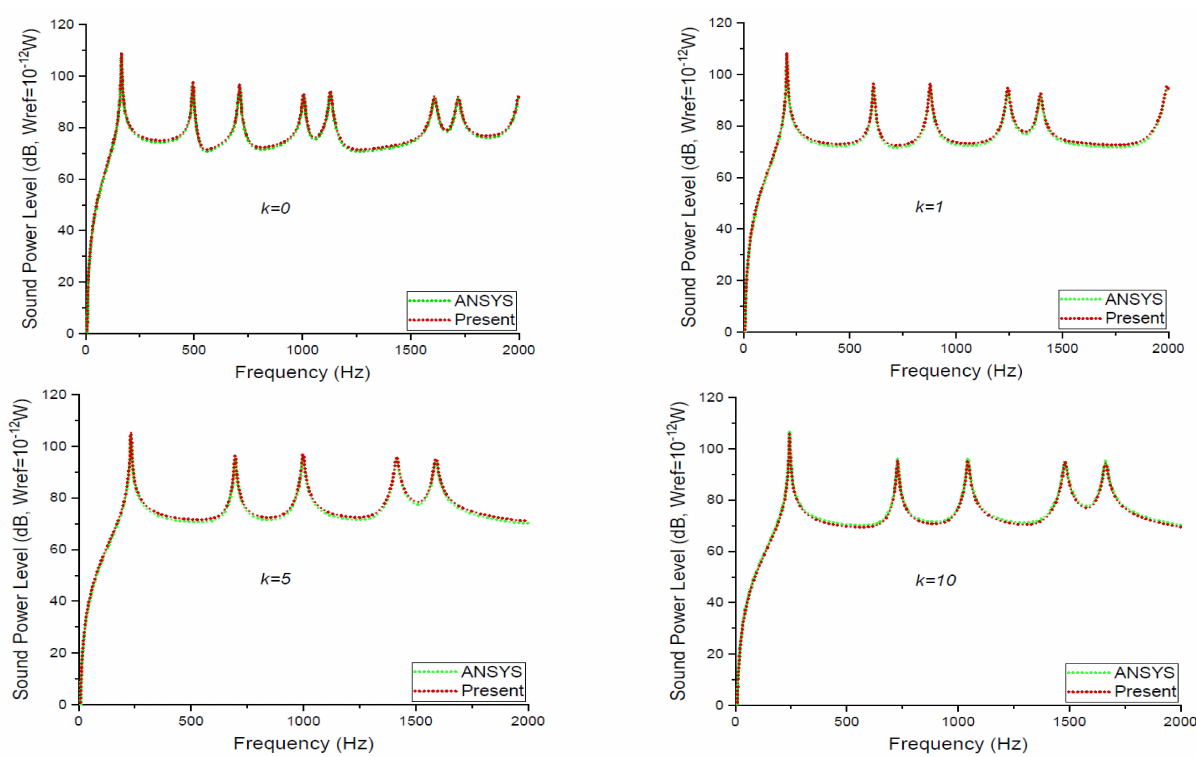
Figure 5. Sound power level with present approach and ANSYS for k = 0, 1, 5, and 10.